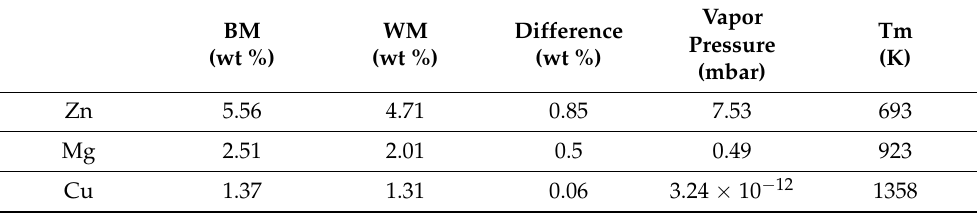
Table 4. Amount of Zn, Mg, and Cu present in parent material and in the weld. BM (wt %)